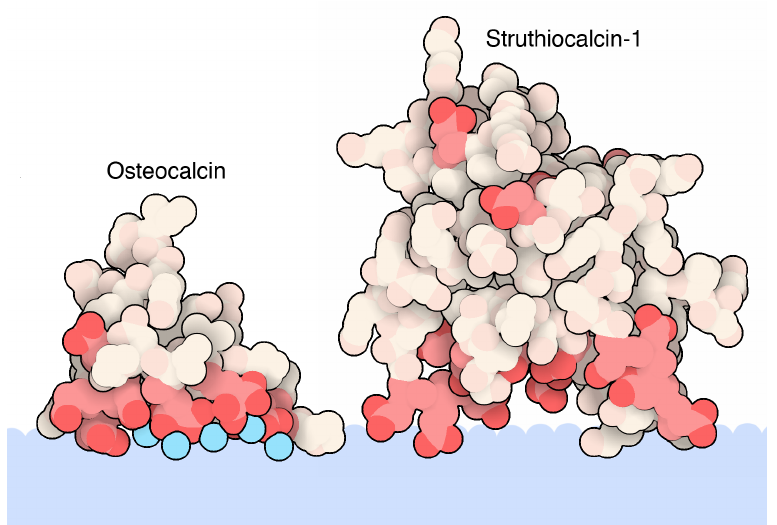
Figure 1. Atomic details of biomineralization proteins binding a calcite biomineral. The biomineal represented as a light blue color shape is interfaced with the rich acidic segment of osteocalcin (PDB accession code 1q8h [42]) and struthiocalcin-1 (PDB accession code 4uww [46]). Both proteins are represented as spheres. Red colors indicate acidic residues (Glu, Gla, and Asp residues). Calcium ions are indicated in cyan colored spheres. This figure is obtained from the Molecule of the Month column “Proteins and Biominerals” (Di Costanzo, L; Goodsell, D. 10.2210/rcsb_pdb/mom_2019_4) [70].